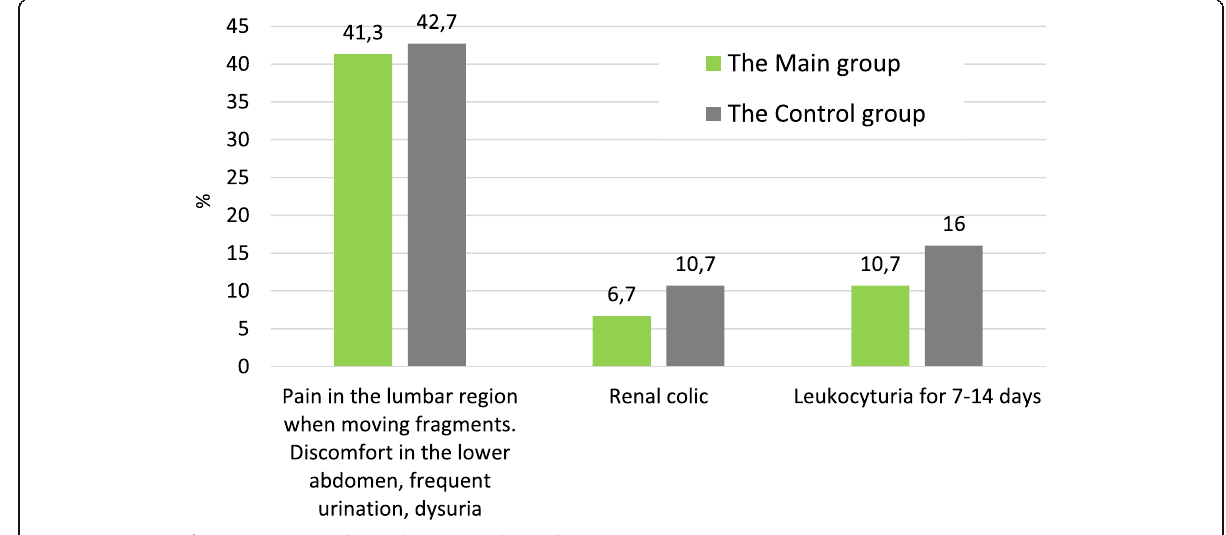
Fig. 2 Frequency of symptoms (%) and complications in the study